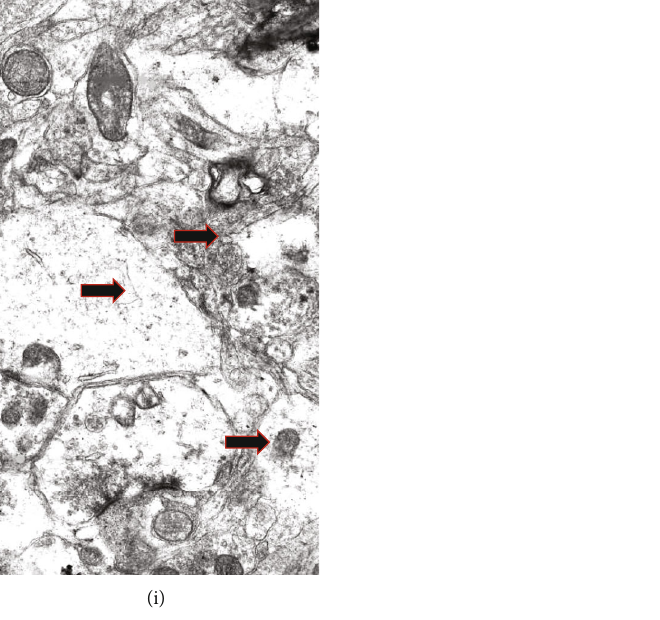
Figure 5: Ultrastructural changes of VMH neurons and glial cells were assessed by electron microscopy observations. Gallery of micrographs obtained by SEM ( n = 12 neurons for each group): (a – c) metformin group; (d – f) PA group; (g – i) metformin and PA group. Representative images of neurons are shown on (a, b, d, e, h, g) and glial cells on (c, f, i). The red arrows indicate the rough endoplasmic reticulum, yellow arrows — mitochondria, white arrows — autophagosomes, and black arrows — neuropil swelling. Scale bar: 200 nm. Table 3: Structural ER parameters after metformin and propionate administration on the background of T2DM. T2DM Control T2DM+PA T2DM+metformin Groups T2DM group +metformin group group and PA group group ) 0 : 453 ± 0 : 05 Relative area of ER membranes (S membr Relative area of ER cisterns (S ) cist